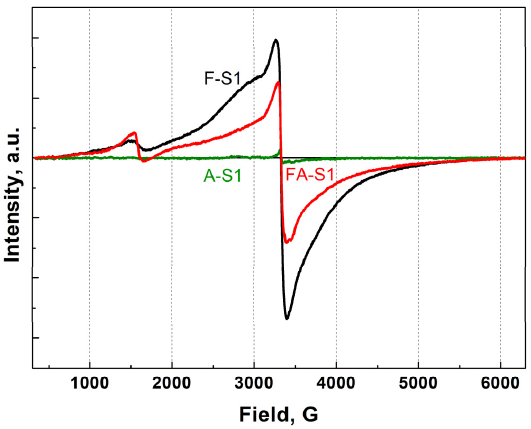
Figure 9. EPR spectra of samples F-S1 (black line), A-S1 (green line) and FA-S1 (red line) at RT.